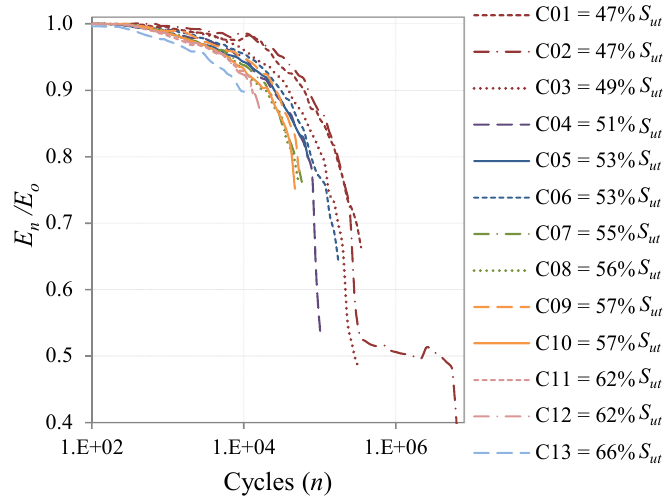
Figure 6. Stiffness degradation of coupons under constant amplitude fatigue loads (CAL) with different maximum load.